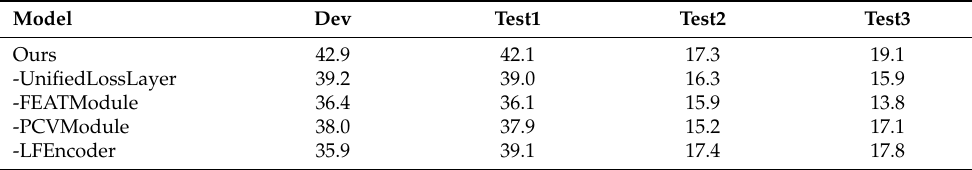
Table 3. Results of the ablation test of our PEINet on each test. For the sake of brevity, the correspond- ing acronym abbreviation is adopted to indicate modules or